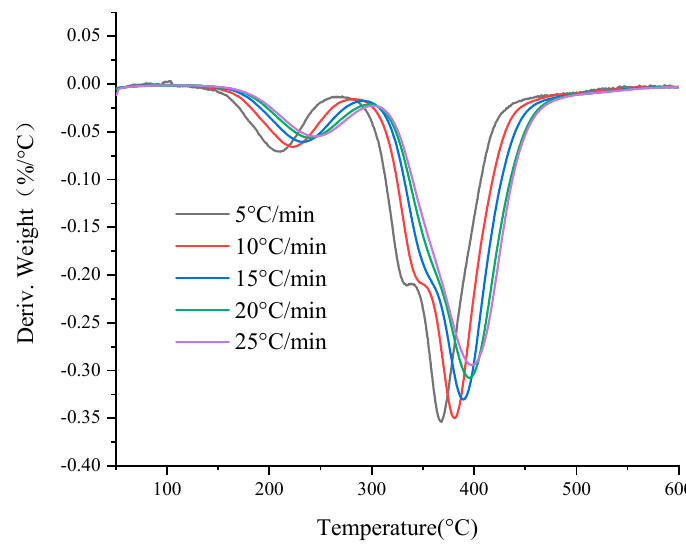
Figure 2. DTG curves of the basin insulator.